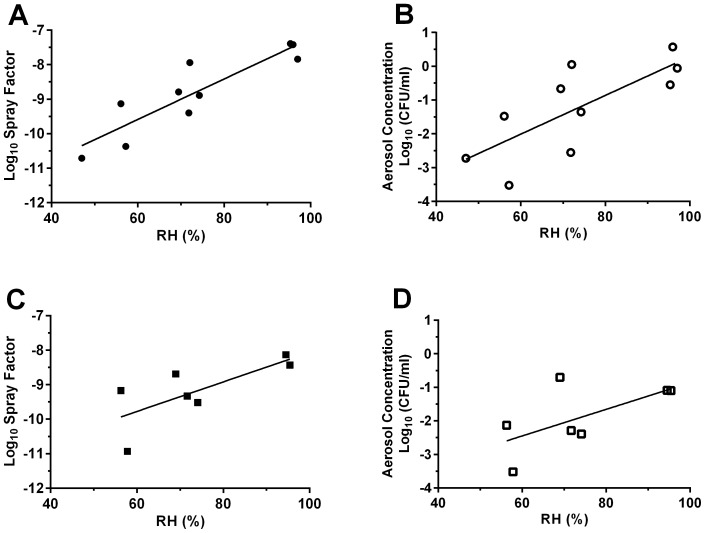
Aerosolization at high humidity increases spray factor and viable aerosols for Cryptococcus during aerosolization in the Madison Chamber.(A and C ) Log spray factor plotted against relative humidity for broth-grown (A) C. neoformans var. grubii H99 (p = 0.0005, R2 = 0.802) and (C) C. gattii EJB18 (p = 0.06, R2 = 0.534). Spray factor increases with relative humidity. (B and D) Log aerosol concentration plotted against relative humidity for broth-grown (B) C. neoformans var. grubii H99 (p = 0.011, R2 = 0.57) and (D) C. gattii EJB18 (p = 0.12, R2 = 0.402). Log aerosol concentration increases with relative humidity. Filled circles and squares represent C. neoformans var. grubii (H99) and open circles and squares represent C. gattii EJB18.